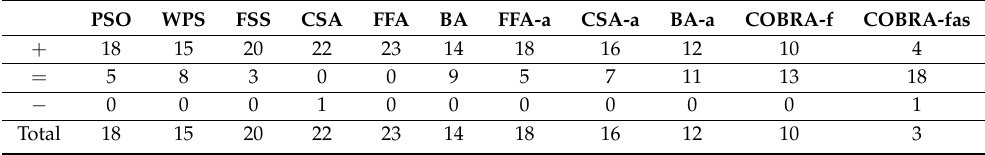
Table 3. Results of the Mann-Whitney statistical test with p = 0.01 for SET-1, comparison of COBRA-SHA with other